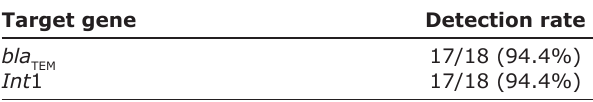
Table-6: Results of PCR detection of target genes.